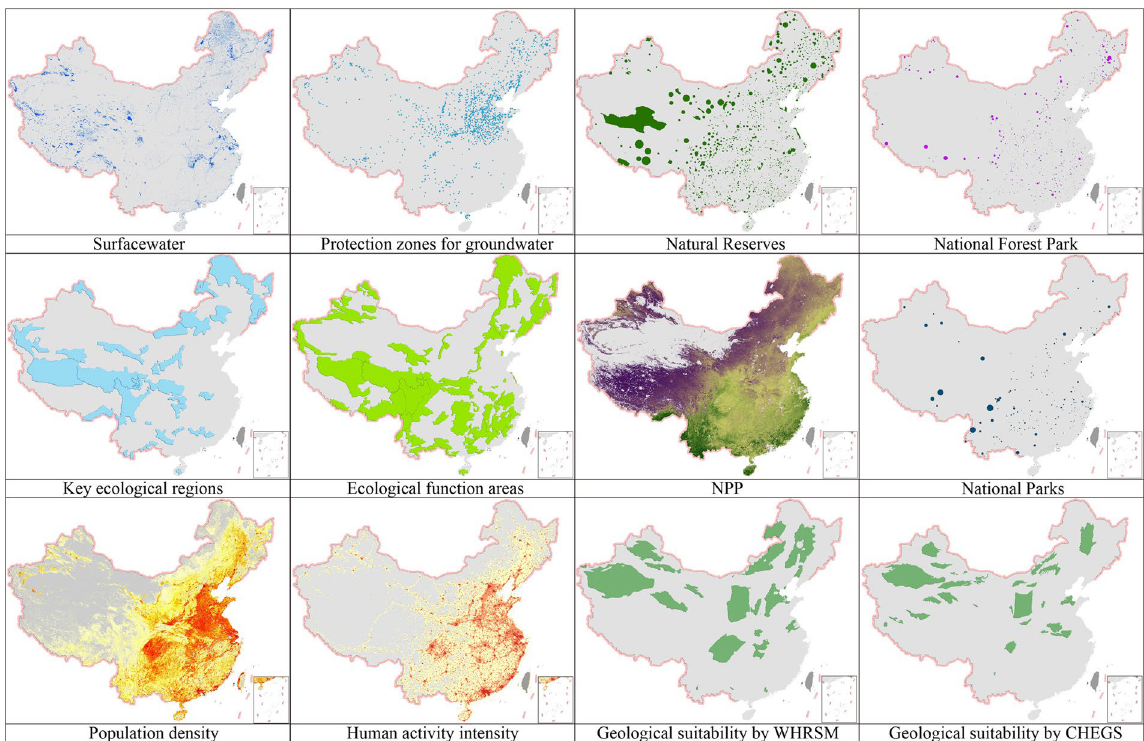
Figure 3. Dataset for basic environmental elements (Sources: Wuhan Institute of Rock and Soil Mechanics, Chinese Academy of Sciences (WHRSM); China Geological Survey Center for Hydrogeology and Environmental Geology Survey, Baoding, China (CHEGS)). Note: NPP, net primary production. The map in this figure were generated by software ArcGIS 9.2 (http://www.esri.com/arcgis/about-arcgis) based on our own data. The China spatial boundary GIS data is from the National Geomatics Center of China (affiliated with National Administration of Surveying, Mapping and Geoinformation of China), which provides the basic GIS data for